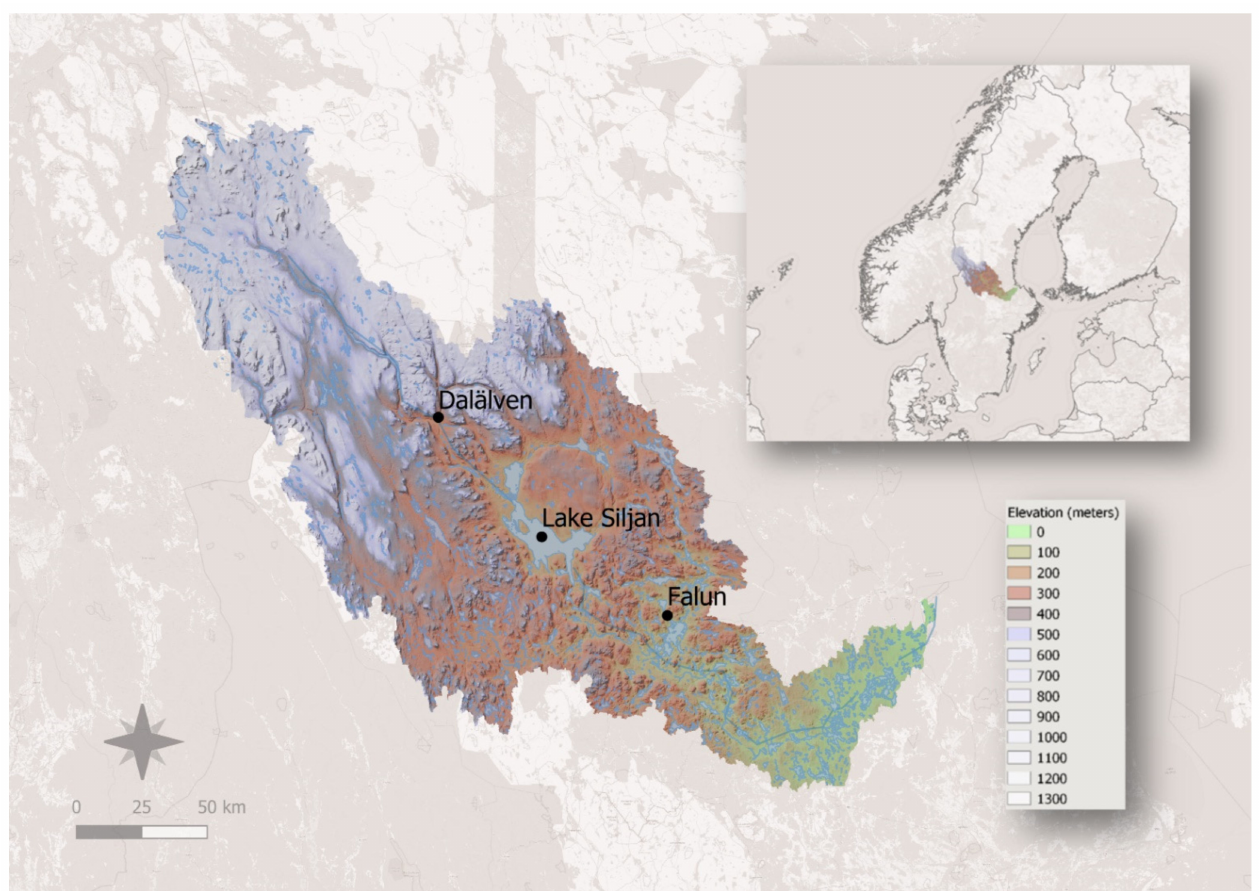
Figure 1. Study area digital elevation map (DEM), Dalälven catchment, Dalarna län; elevation DTM 50 m© Lantmäteriverket; shoreline data provided by Strandnivåer Rikstäckande at 1800 CE© SGU; rivers and boundaries shapefiles courtesy of the European Environmental Agency (EEA); background map© OpenStreetMap contributors